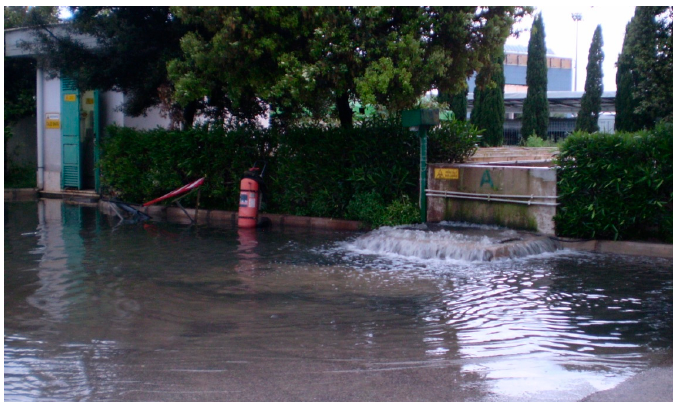
Figure 8. Rainfall depth: events on 2 October and 5 October 2021.